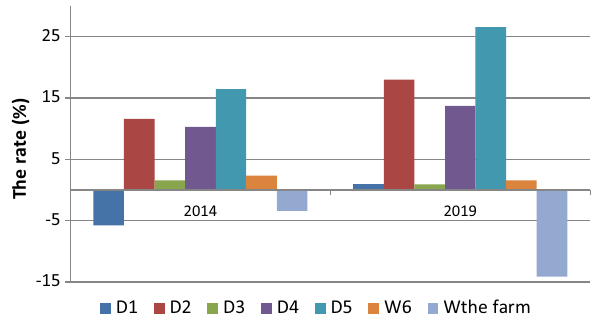
Fig.6 The rate of change in conductivity between 2014 and